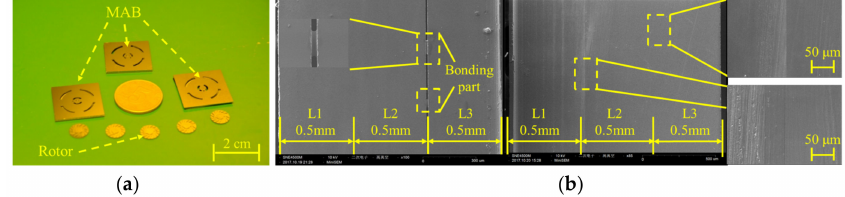
Figure 13. Diced MAB device and bonding status in the interface. ( a ) Photo of three-layer MABs and their micro rotor; and, ( b ) SEM image of bonding interface with poor and good bonding